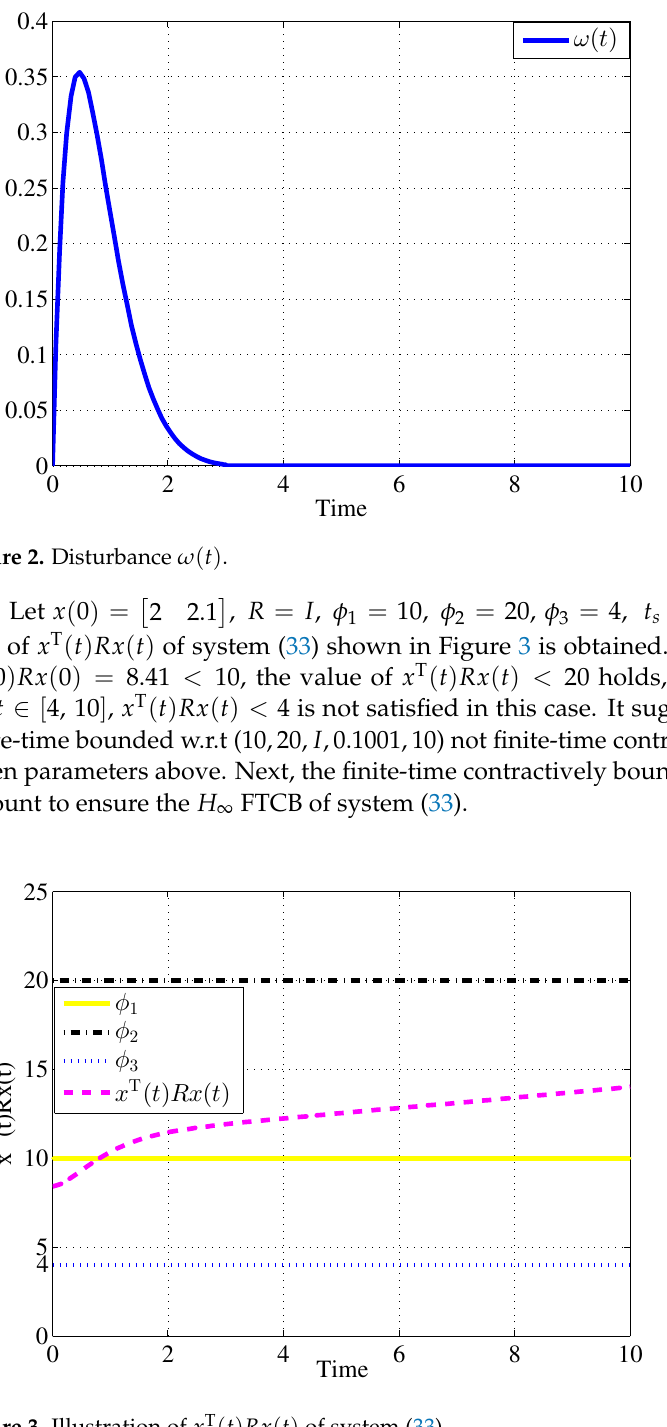
Figure 3. Illustration of x T ( t ) Rx ( t ) of system